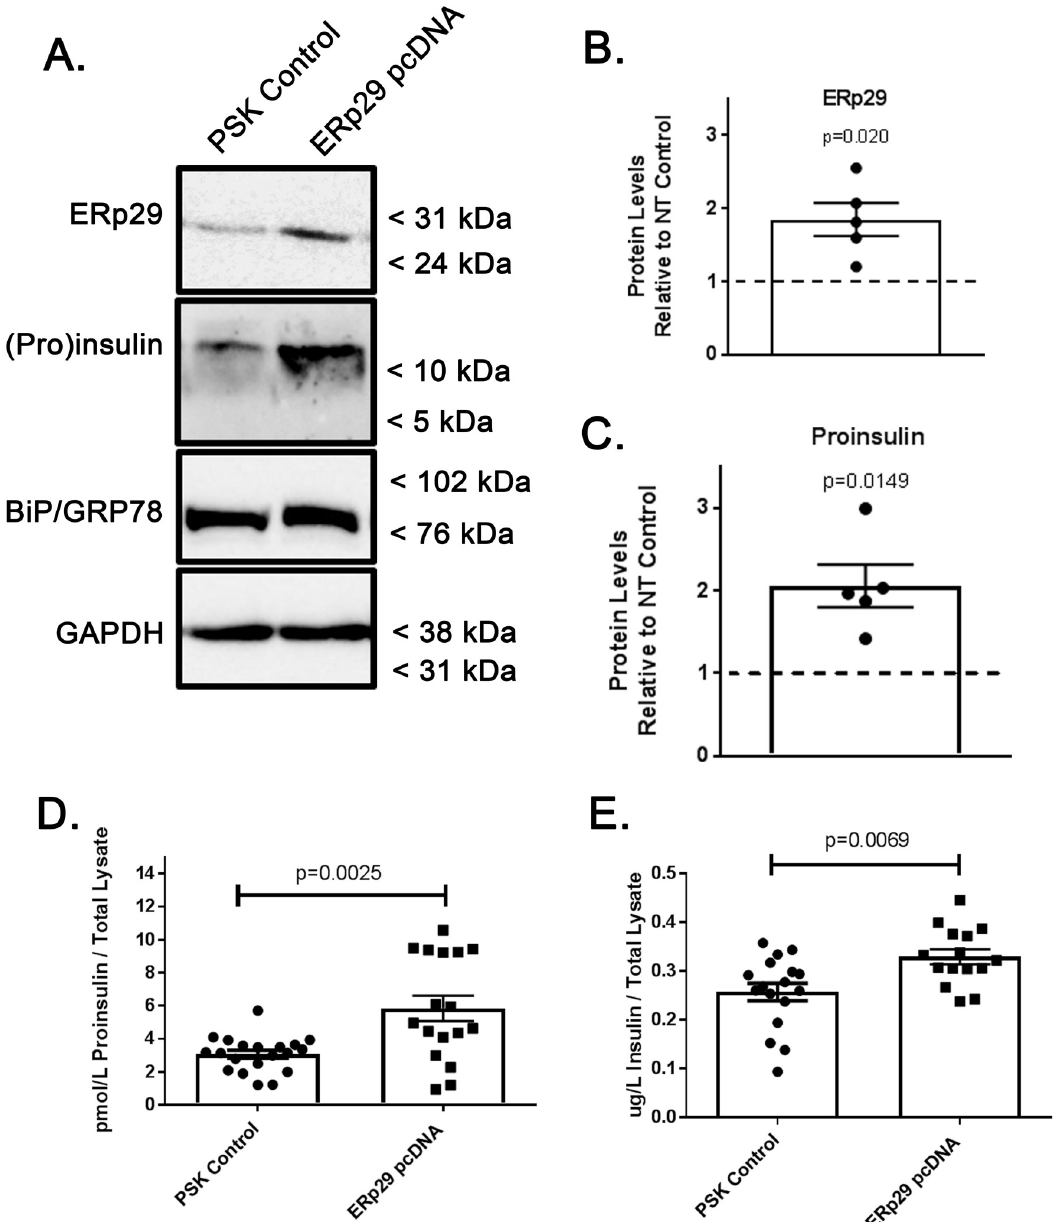
Fig 5. Overexpression of ERp29 increases cellular Proinsulin and Insulin. Min-6 cells were transiently transfected with a pcDNA4 plasmid expressing WT ERp29 or with a non-expressing PSK control plasmid, and whole cell lysates were prepared. (A) ERp29 and Proinsulin abundance was assayed in whole cell lysates by immunoblot. Immunoreactivity of GAPDH was used as a loading control, and immunoreactivity of BiP was used to monitor for ER stress. These data are representative of n = 5 independent experiments. Densitometry of ERp29 (B, p = 0.020) and Proinsulin (C, p = 0.0149) in immunoblots. (D, E) Lysates of transfected control or WT ERp29 transfected Min-6 cells were analyzed by ELISA, and data demonstrate an increase in both cellular Proinsulin (D, p = 0.0025) and Insulin (E, p = 0.0069) when compared to